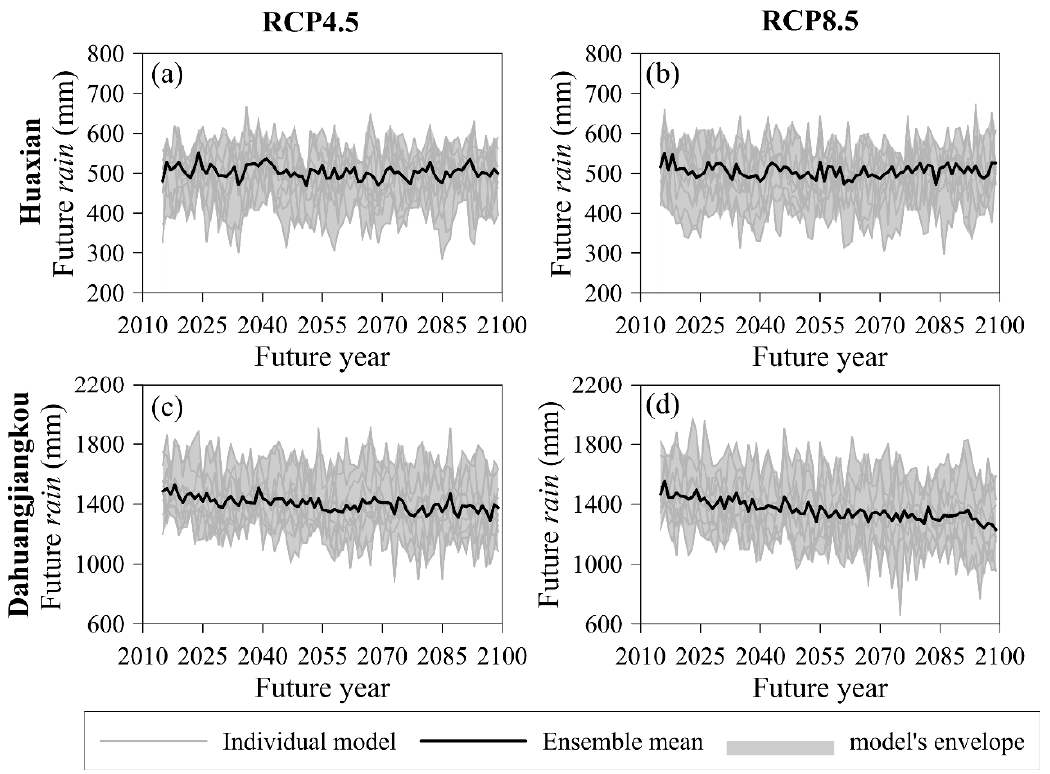
Figure 5. Projected future rain by using outputs of different general circulation models (GCMs) under RCP 4.5 and RCP 8.5 emission scenarios for the period of 2015–2099 as done by Yan et al. [19]. The ensemble mean is the arithmetic mean of different GCMs. ( a ) and ( b ) are RCP 4.5 and RCP 8.5 for Huaxian station; ( c ) and ( d ) are RCP 4.5 and RCP 8.5 for Dahuangjiangkou station.